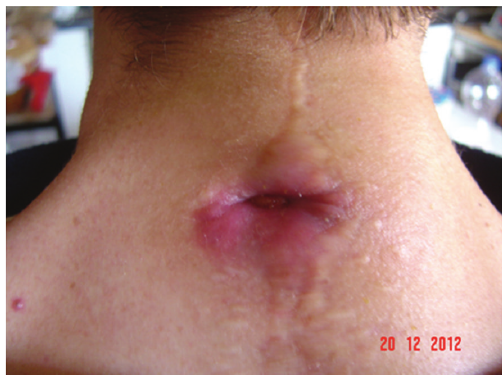
Figure 3: Significant reduction of the granuloma size after a thirty-day antibiotic treatment with amoxicillin/clavulanate and